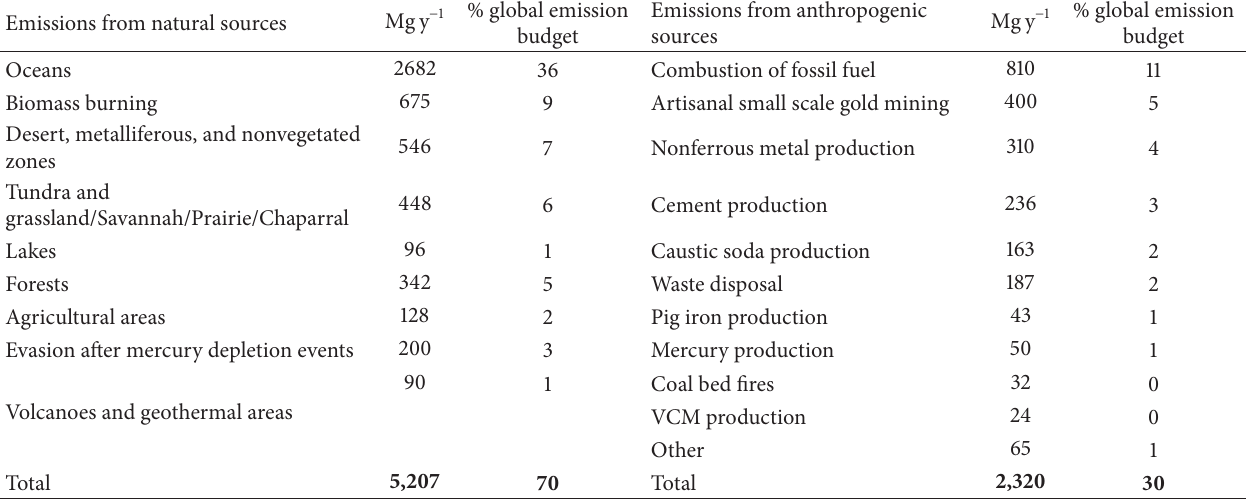
Table 10: Mercury emissions from natural and anthropogenic sources [193].